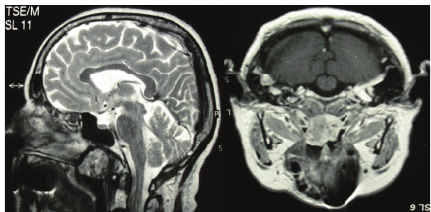
Figure 1: Magnetic Resonance. A mass connected to the lateral wall of nasopharynx space is identified. The lesion does not infiltrate the adjacent tissue and had lobed margins.